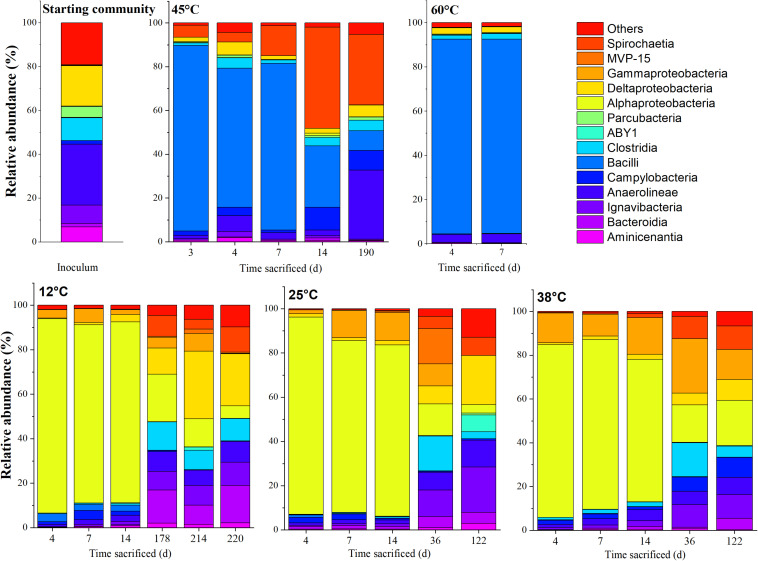
Time-resolved distribution of the bacterial community composition of the community assigned to order. Members which constitute < 5.0% across all samples were grouped as others.